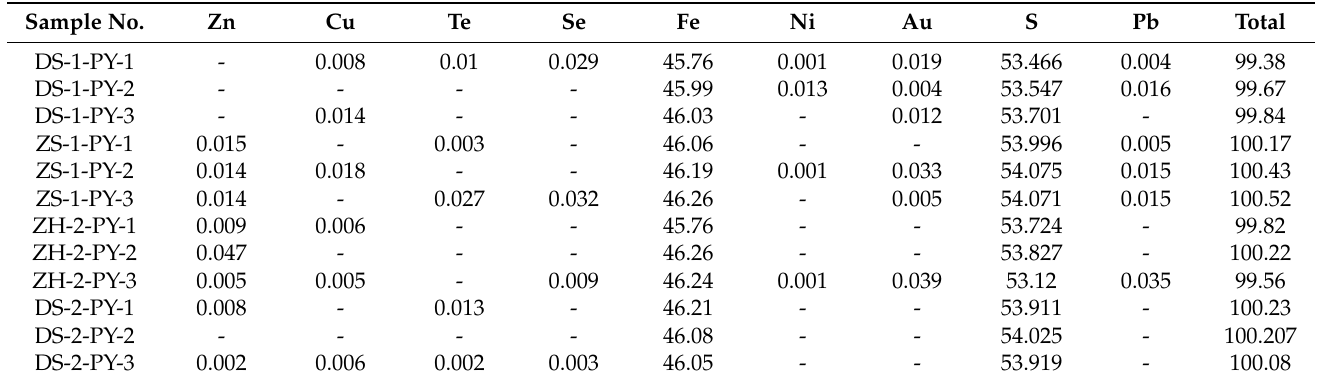
Table 3. Selected EPMA analyses of pyrite grains from the Dongping deposit (wt.%). Sample